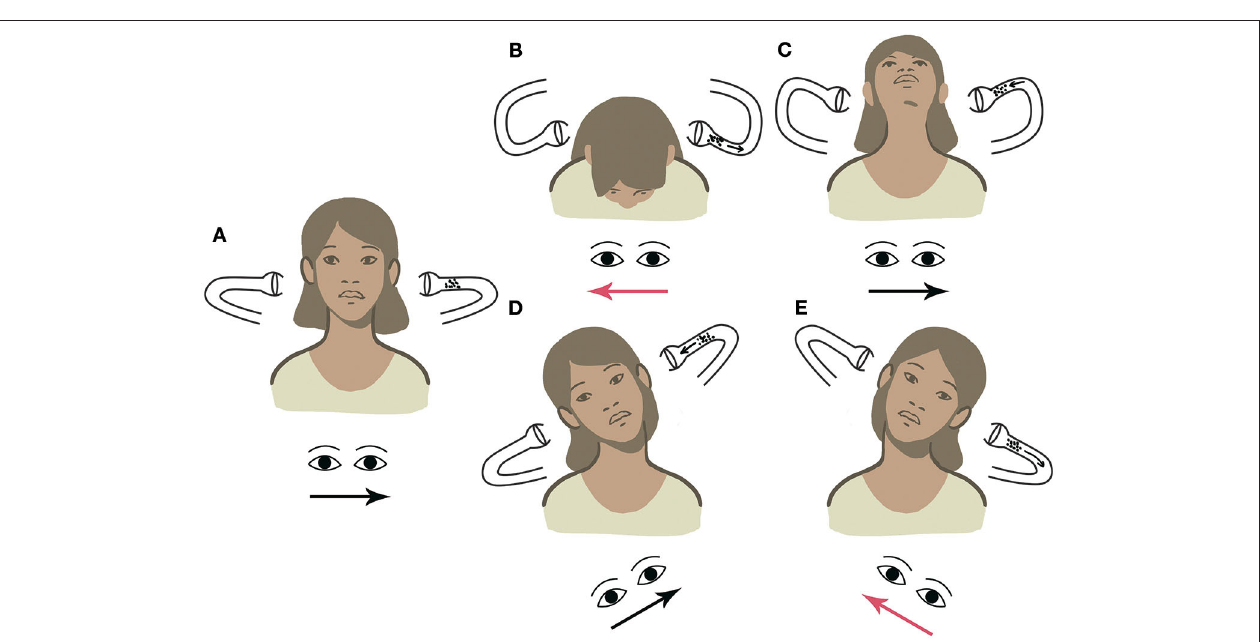
FIGURE 7 | UBP for left apogeotropic LSC-BPPV. (A) PSN: left beating. (B) HPT with forward head bending: right-beating nystagmus. (C) HPT with backward head bending: left-beating nystagmus. (D) UHRT with rightward head tilt: left-beating apogeotropic nystagmus. (E) UHRT with leftward head tilt: right-beating apogeotropic